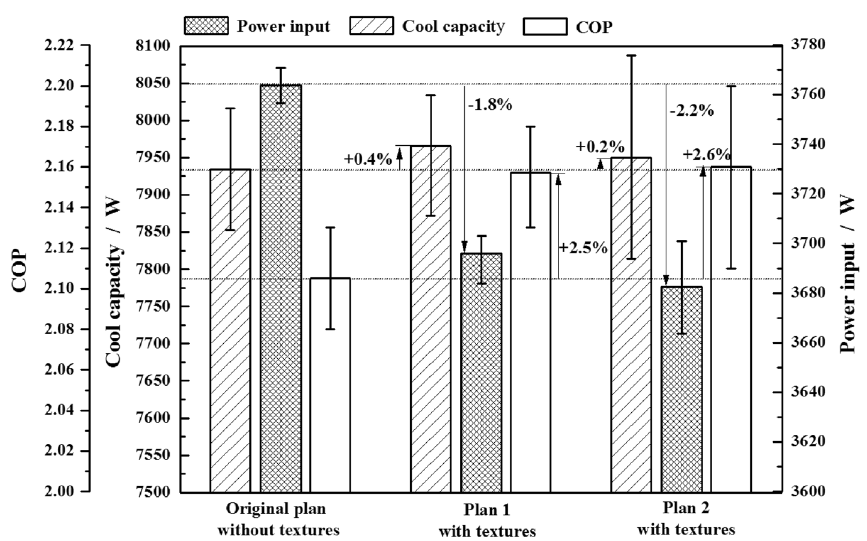
Figure 14. Comparisons of compressor performance for different